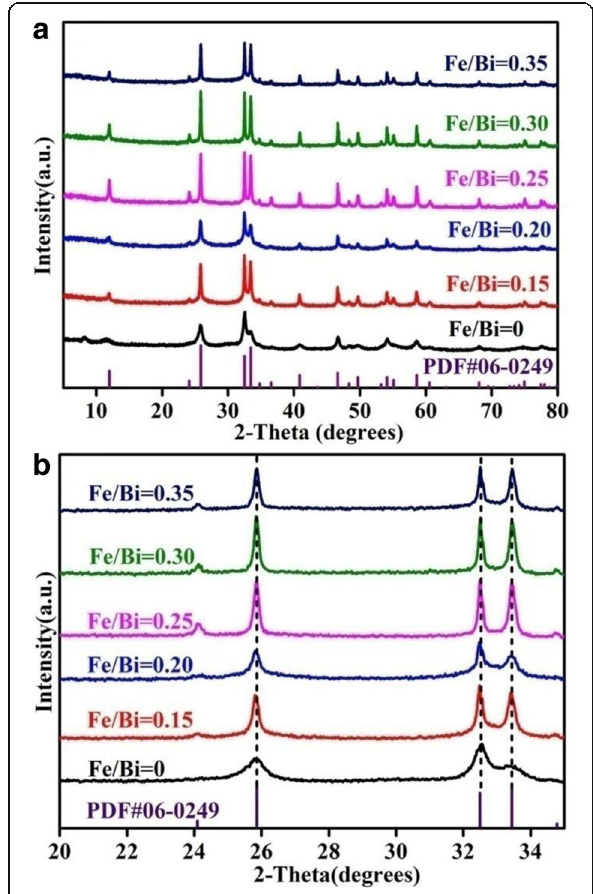
Fig. 1 Wide XRD patterns ( a ) and local XRD patterns ( b ) of Fe/BiOCl ( x